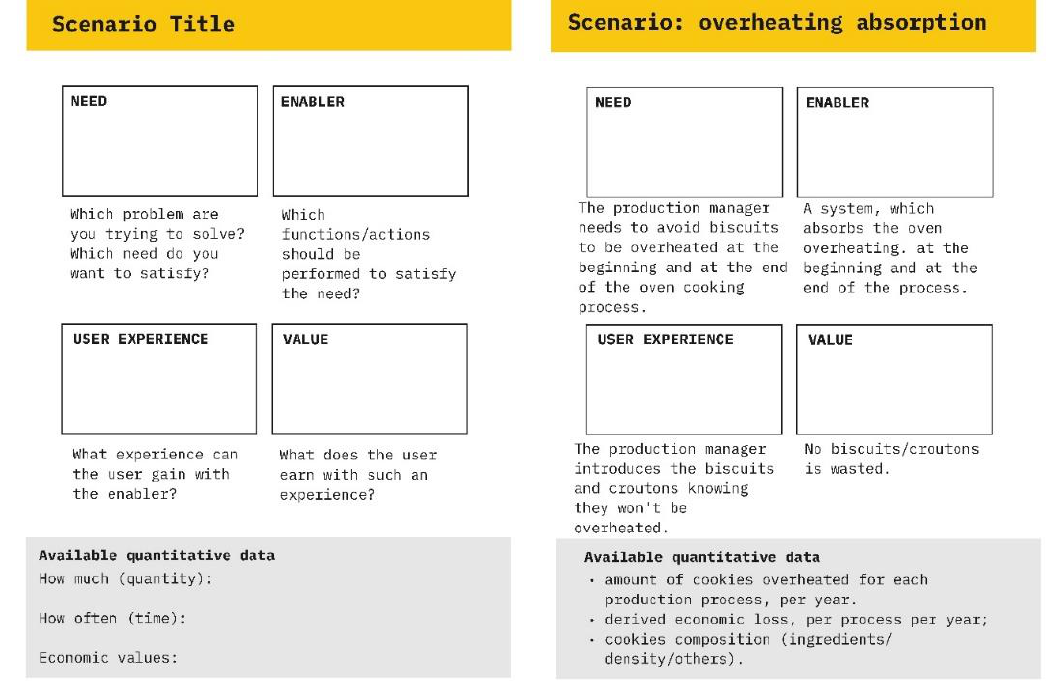
Fig. 5. Tech Functional